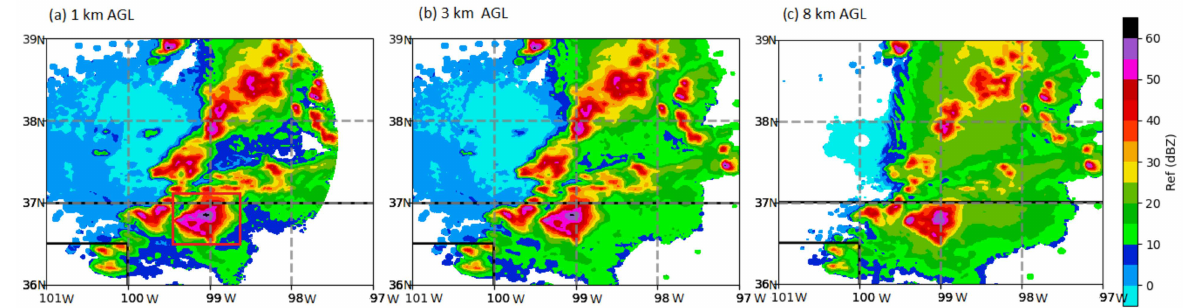
Figure 3. Z H at ( a ) 1 km, ( b ) 3 km, and ( c ) 8 km height collected by KDDC radar on 2346 UTC 29 May 2018. The red box in the left panel shows the location of the hail storm that is discussed further in Section